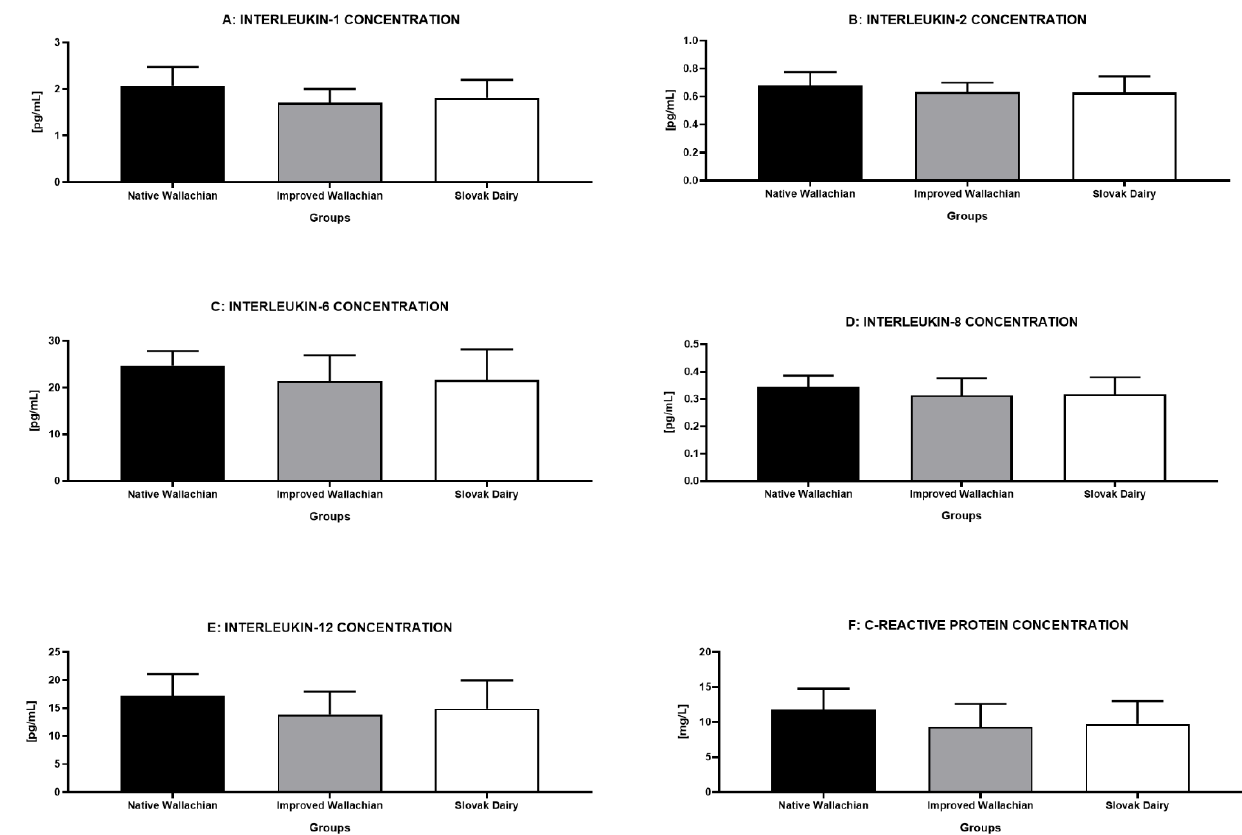
Figure 7. Comparative analysis of the pro-inflammatory markers among the pre-established groups of ram semen samples.